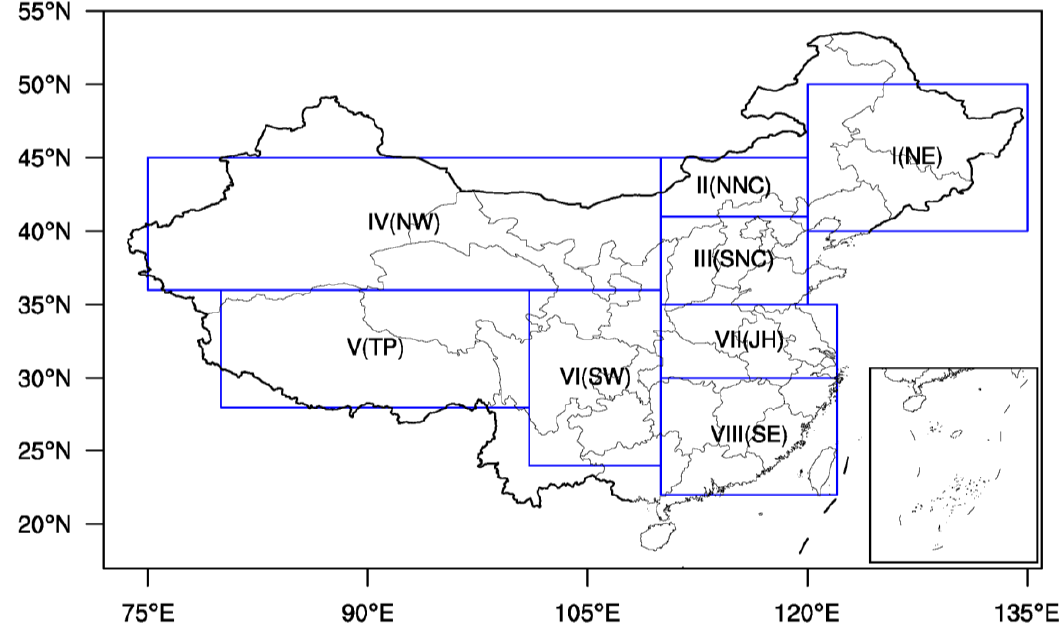
Figure 1. The study domain and its eight subregions marked with blue boxes. The eight subregions